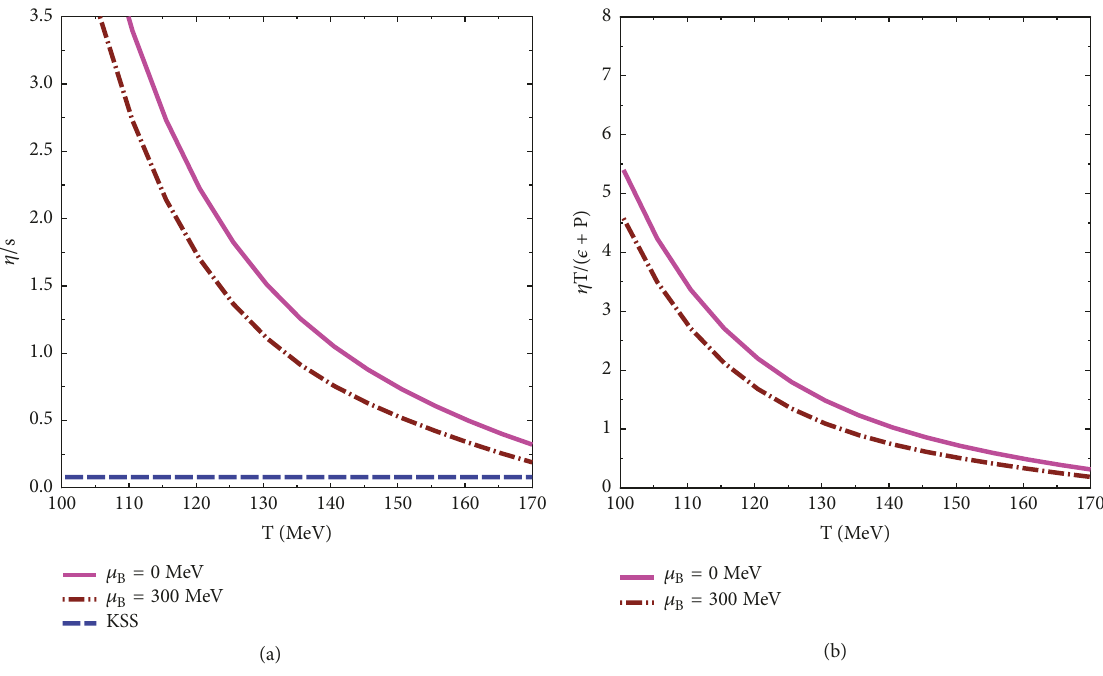
Figure 5: (a) shows 𝜂/𝑠 estimated within the MEHRG model at 𝜇 𝐵 = 0 and 300 MeV. The blue dashed curve corresponds to KSS bound, 𝜂/𝑠 = 1/4𝜋 . (b) shows the fluidity measure 𝜂𝑇/(𝜖 + 𝑃) estimated within MEHRG at 𝜇